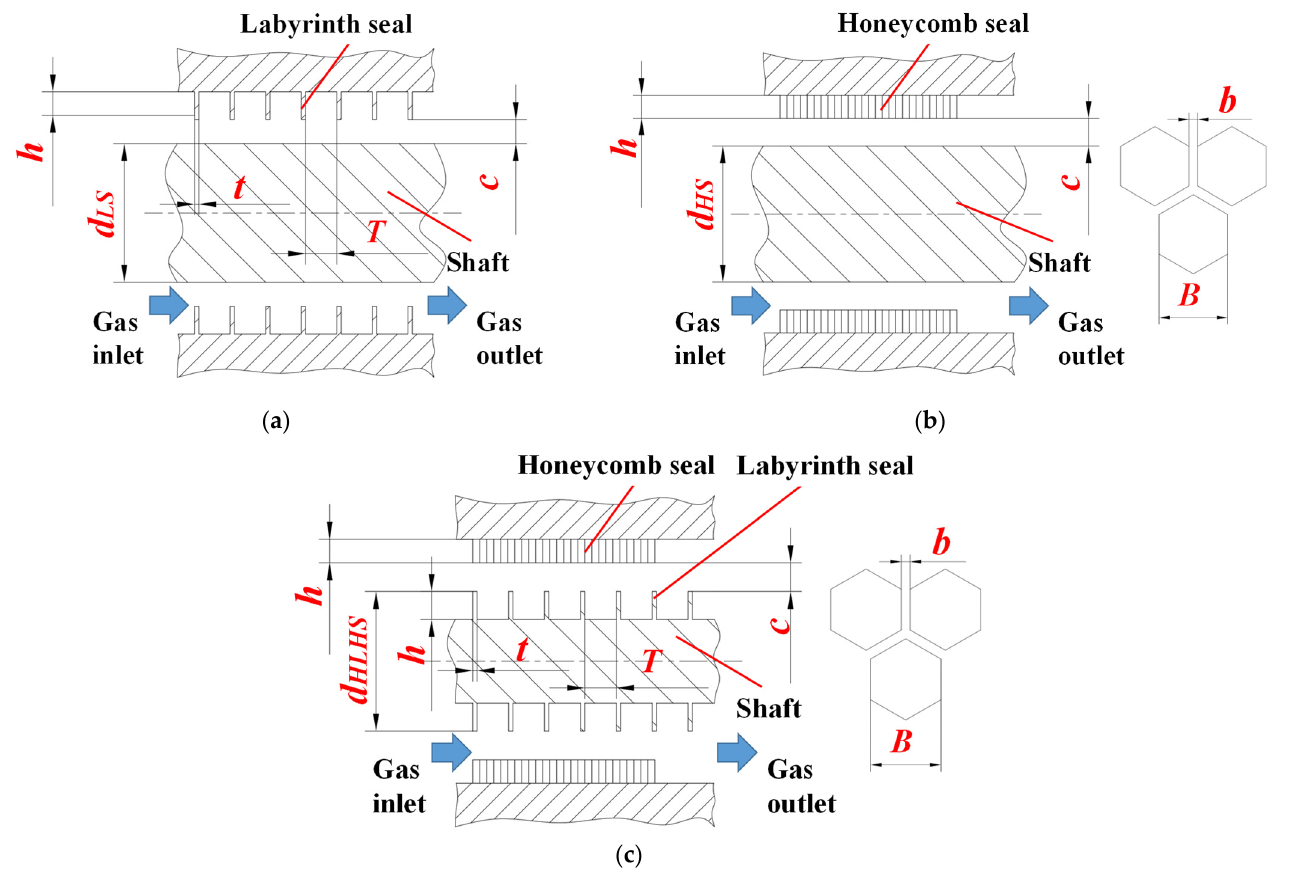
Figure 1. Structural diagram of three types of seals. ( a ) Labyrinth seal; ( b ) honeycomb seal; ( c ) hybrid labyrinth–honeycomb seal.